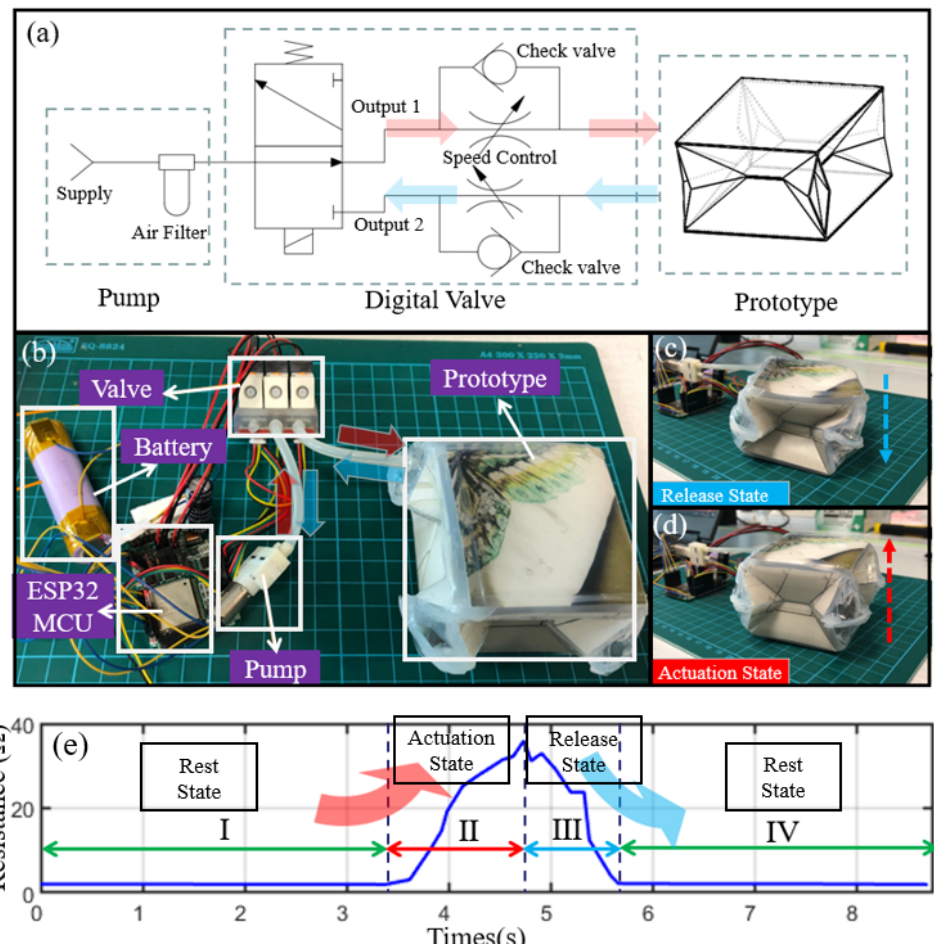
Figure 11. ( a ) Represents the air path diagram, where the whole system is divided into the air pump part, the digital valve controlled by the ESP32 MCU, and the foldable prototype. ( b ) There is a basic experimental setup for the pneumatic actuation of our prototype, and the valve is controlled by ESP32- MCU to realize the switch on intake or exhaust state; ( c , d ) indicate the two working states: the release state when exhausting and the actuation state when intaking. ( e ) The real-time resistance acquisition curve of our microfiber sensor can precisely record the air pressure change inside the foldable structure when intaking air with a constant pressure of 100.524 kPa. The foldable structure’s state is changed from I. Rest State; II. Actuation State; III. Release State; and finally back to the IV. Rest